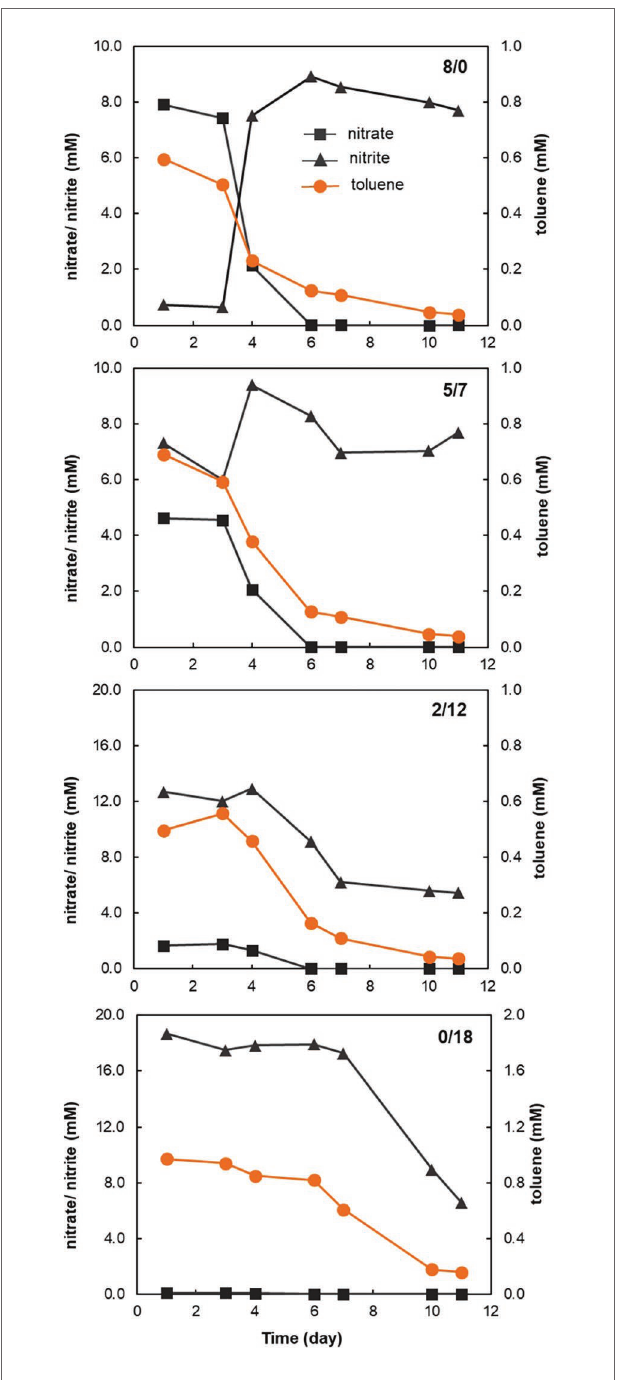
FIGURE 1 | Activity of nitrate, nitrite reduction and toluene oxidation in all except the control treatment microcosms. The first 7 days data are the average of three replicate incubations, while the other data points are the average of the two rest incubations. The 8/0 panel represents the results of the microcosm contained 8/0 mM (nitrate/nitrite) as electron acceptors; the 5/7 panel represents the results of the microcosm contained 5/7 mM (nitrate/nitrite) as electron acceptors; the 2/12 panel represents the results of the microcosm contained 2/12 mM (nitrate/nitrite) as electron acceptors; and the 0/18 panel represents the results of the microcosm contained 0/18 mM (nitrate/nitrite) as electron